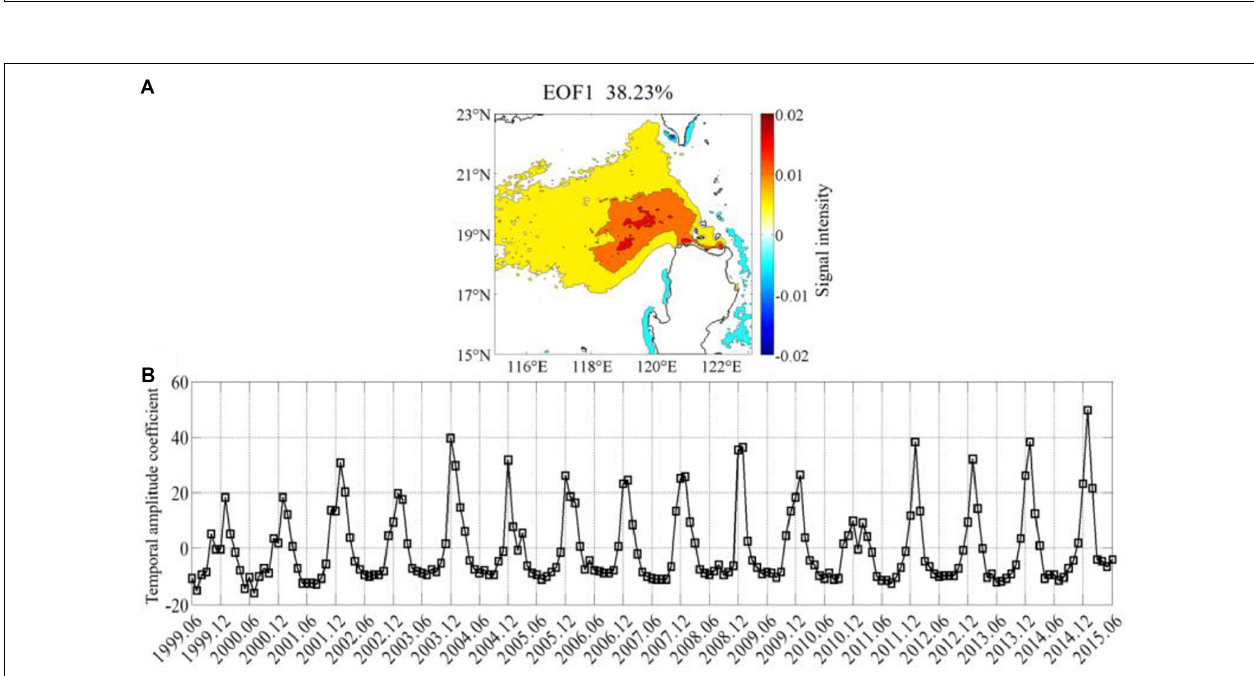
FIGURE 3 | The first EOF mode of the chlorophyll- a concentration in the study area: (A) spatial pattern of the first EOF mode, the percentage of variance explained is 38.23%; (B) time series of the amplitude of the first EOF mode (The Chl- a data in EOF analysis is investigated in the offshore region with water depth over 200 m).